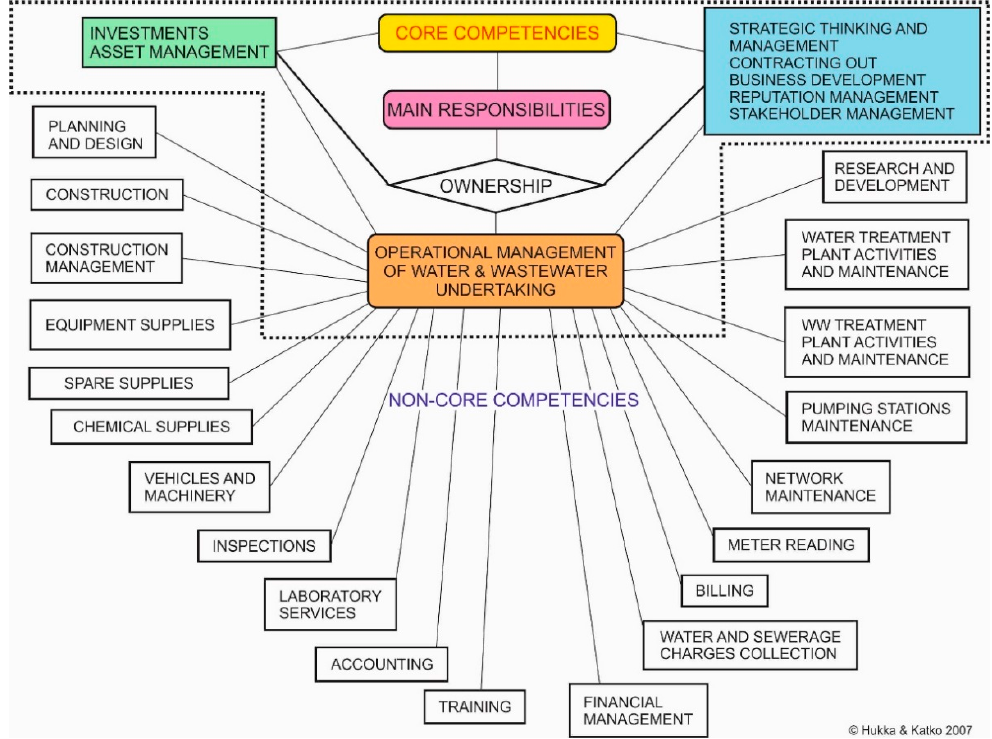
Figure 2. Core and non-core competencies for water and wastewater management [29] (p. 314), modified [30] (p. 9).